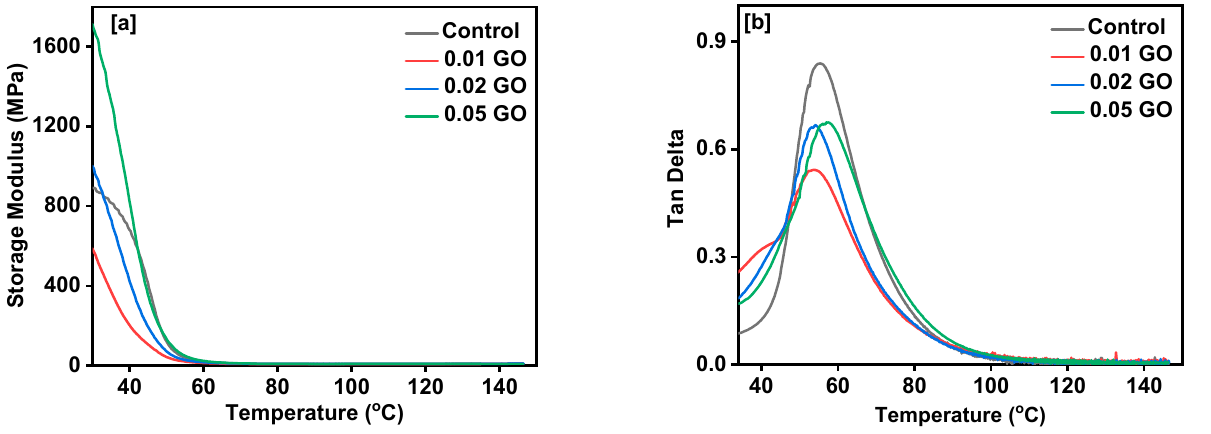
Figure 7. Dynamic mechanical properties of GO-based films as a function of temperature: ( a ) storage modulus and ( b ) tan delta.